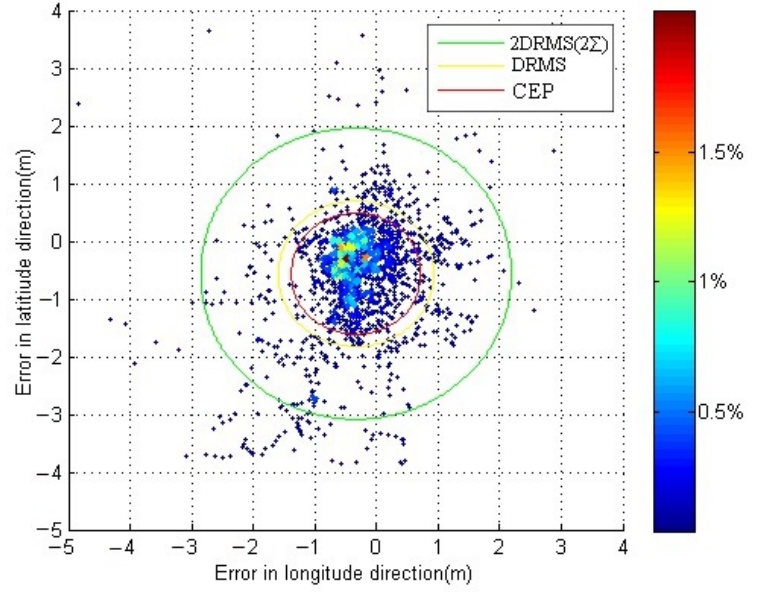
Figure 10. Scatter plot of the position errors for the dynamic positioning